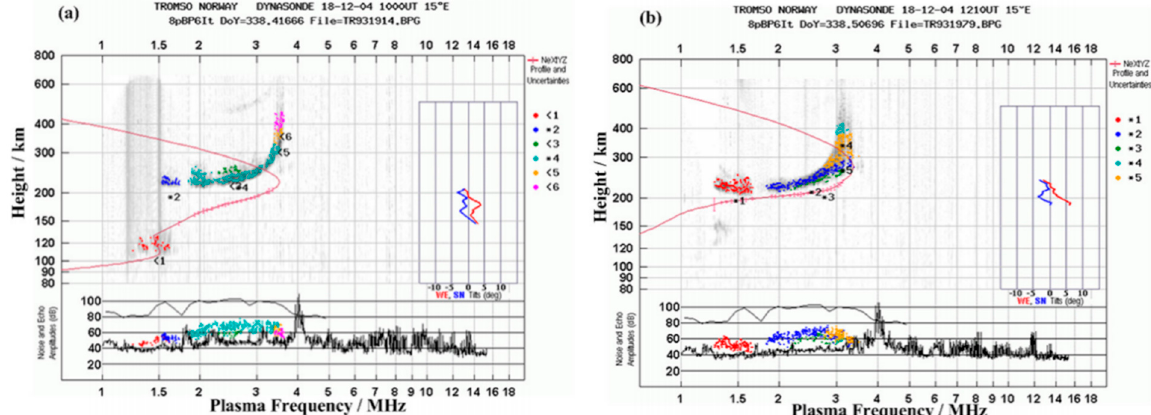
Figure 5. Status of the ionosphere during the experiments on December 4, 2018 ( a ) 1000 UT and ( b ) 1210 UT at Tromsø, EISCAT (reprinted from [23], with the permission of AIP Publishing). Table 1. Comparison of simulation results with experimental observations.